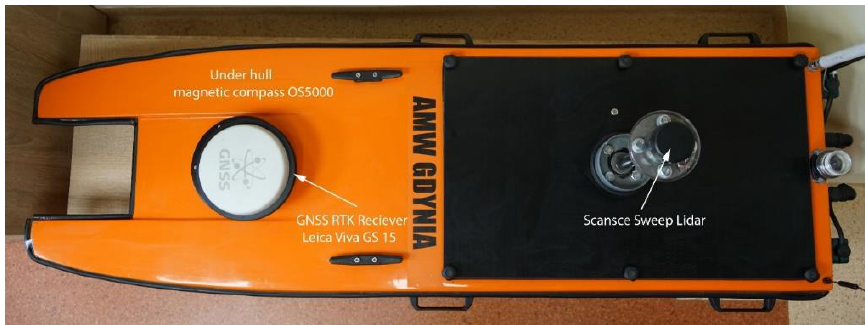
Figure 10. The distribution of measuring instruments on the unmanned surface vehicle (USV).